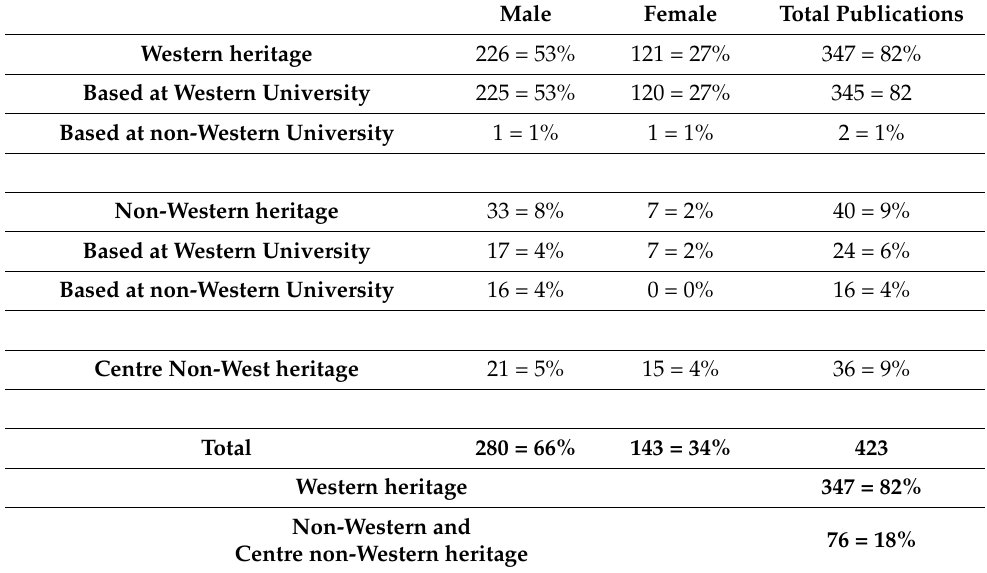
Table A6. Studies in conflict and terrorism.